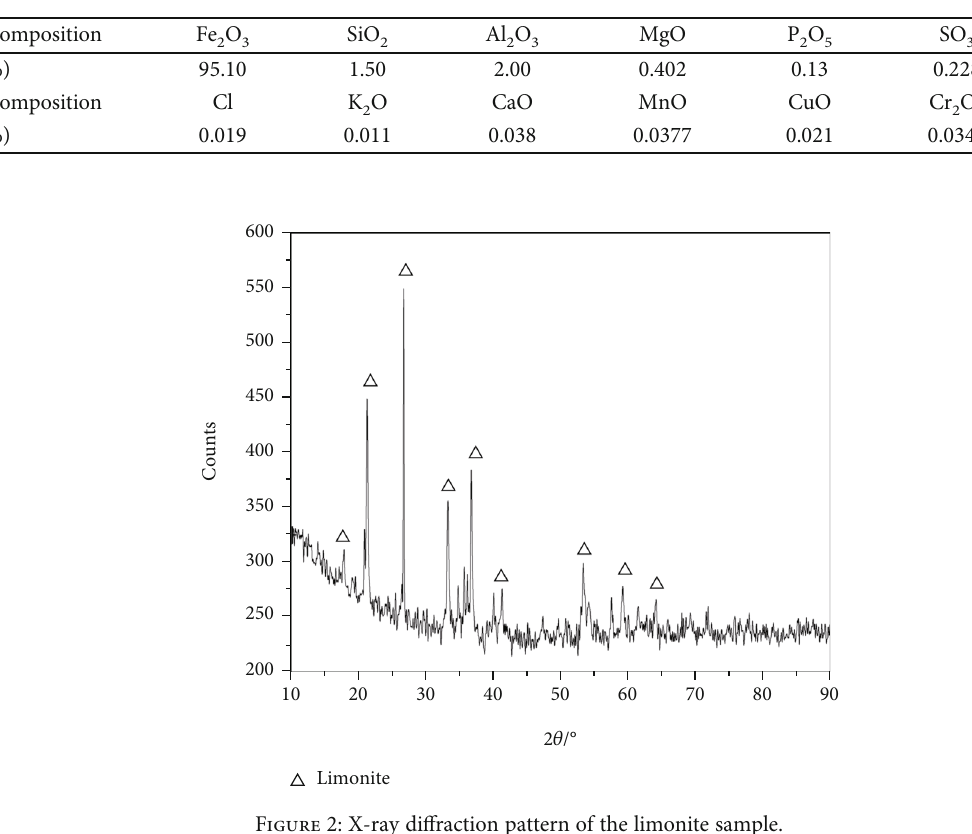
Table 2: Chemical composition analysis of limonite.